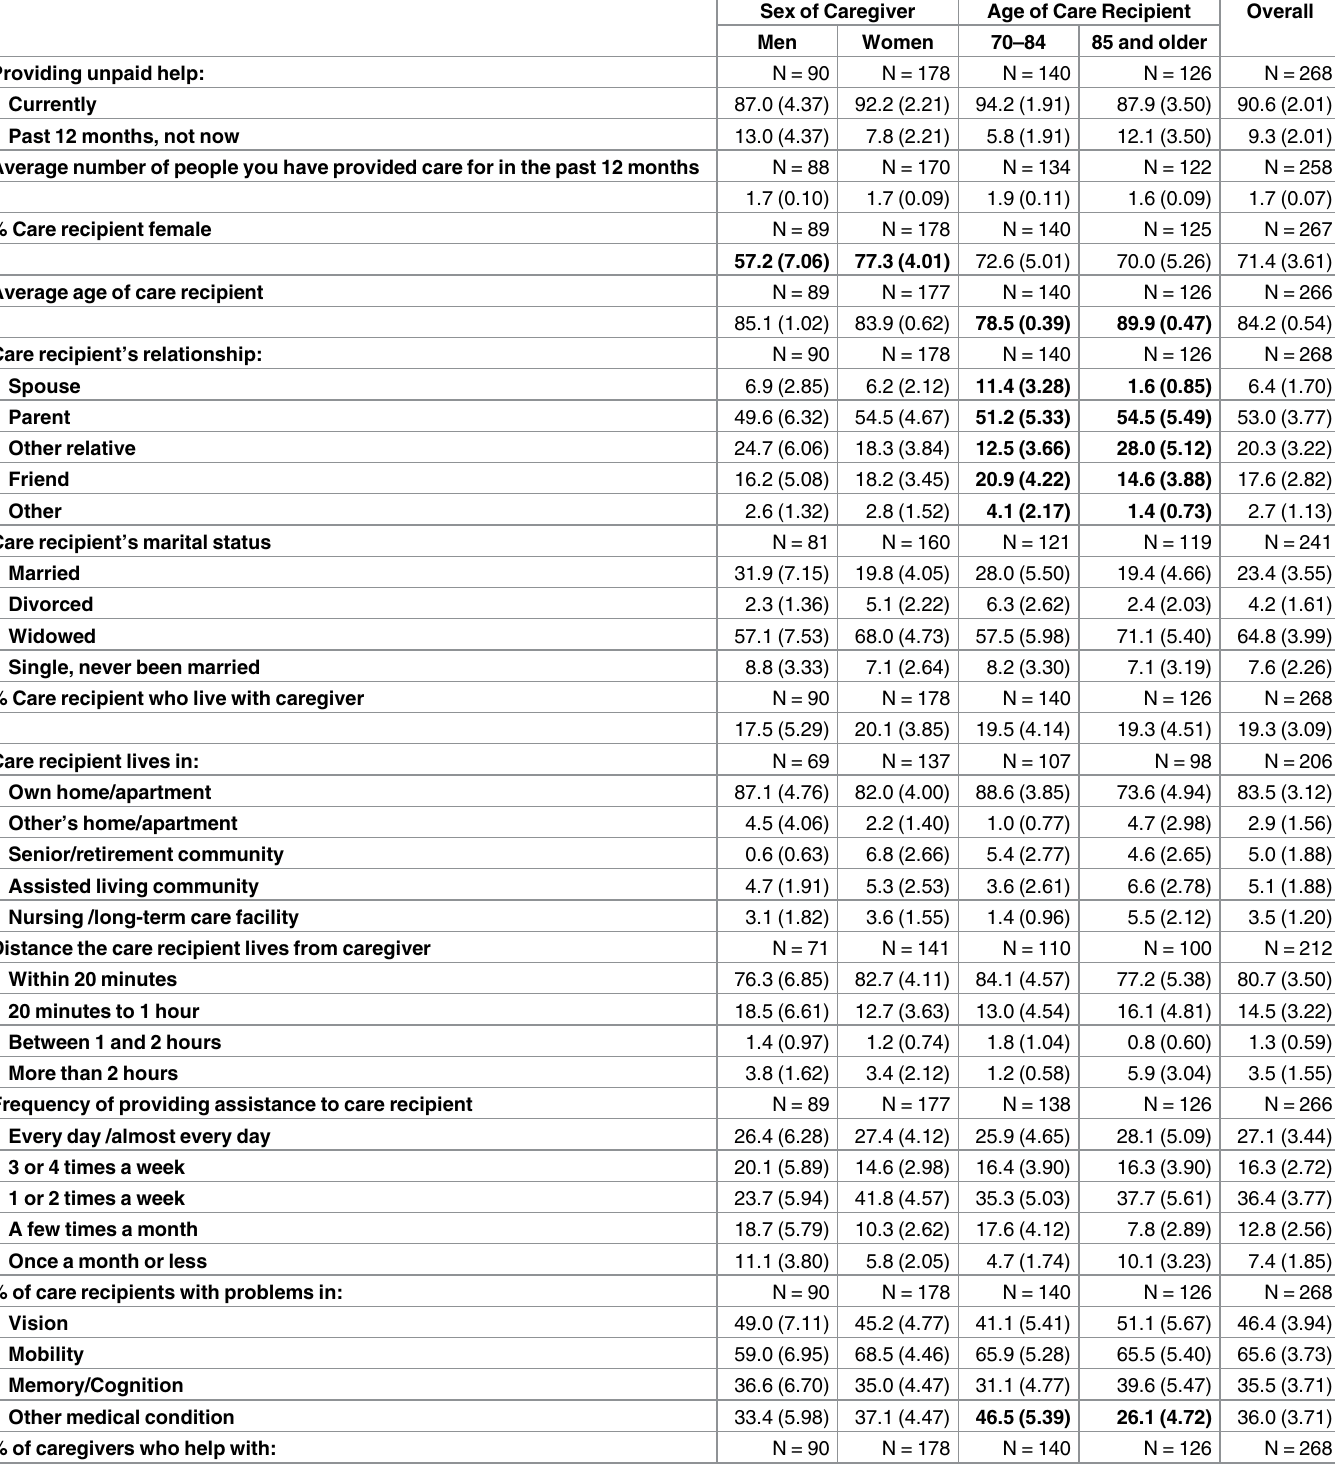
Table 4. Recipients and caregiverinformation by transportation caregiversex, age of care recipient, and overall (standard error of the percent/